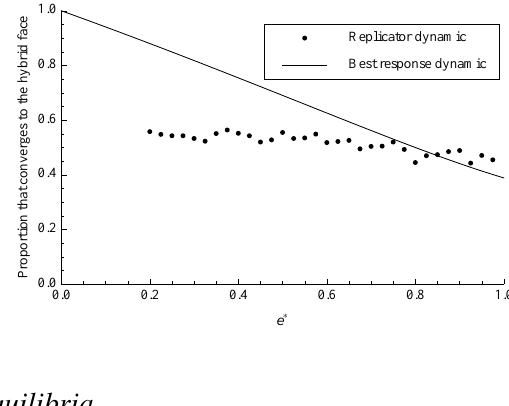
Figure 6. The proportion of phase space that converges to the x = . 5 . Each data point for the replicator dynamic is the average of both dynamics with p H 1000 randomly chosen initial conditions.